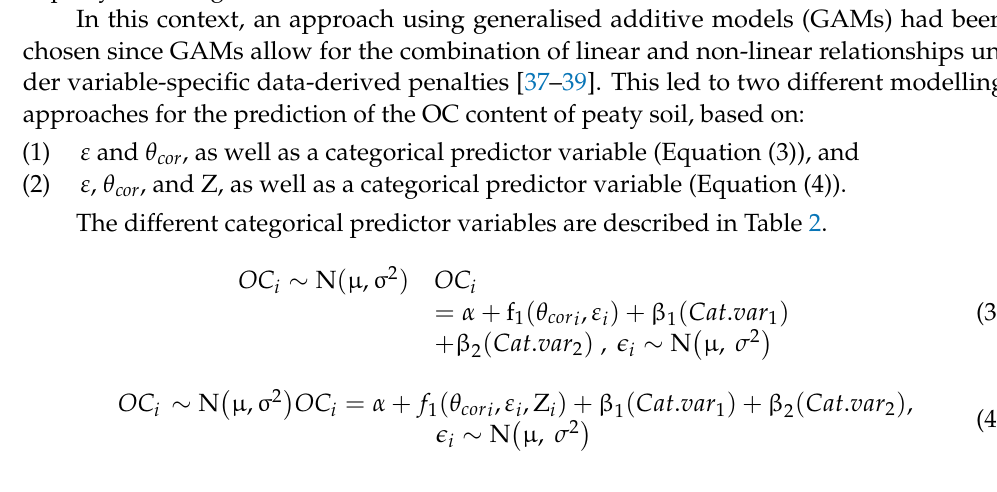
Table 2. Generalised additive models (GAM) tested for the prediction of organic carbon content. The model names are a combination of the continuous and categorical variables included, as indicated by abbreviations in brackets in the model equations. θ cor ( W ) is the, by Equations (1) and (2), corrected volumetric water content in peaty soil, ε (K) is the dielectric permittivity, and Z (I) is the probe